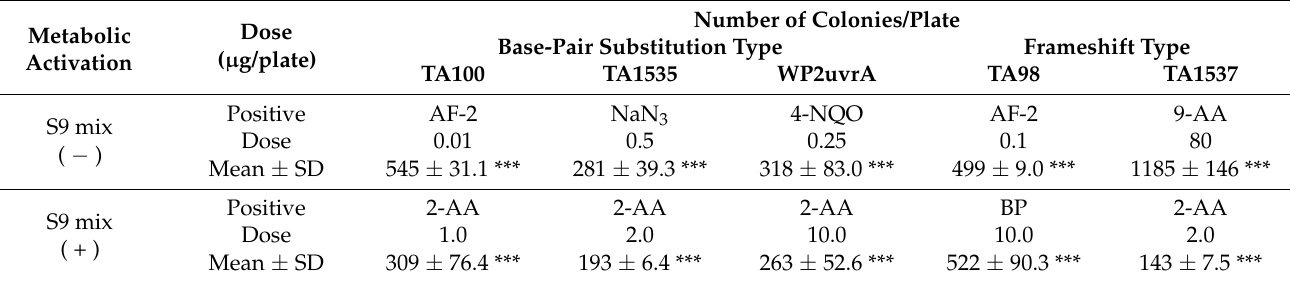
Figure 1. Fingerprint analysis: fingerprint analysis of four ( A ) standard compounds and ( B ) Rhus verniciflua Stokes without bark (RVX) using ultra-high-performance liquid chromatography-tandem mass spectrometry (UHPLC-MS/MS). ( C ) Quantitative analysis of RVX was performed by ChemStation software. Table 1. Positive agents for bacterial reverse mutations with or without S9